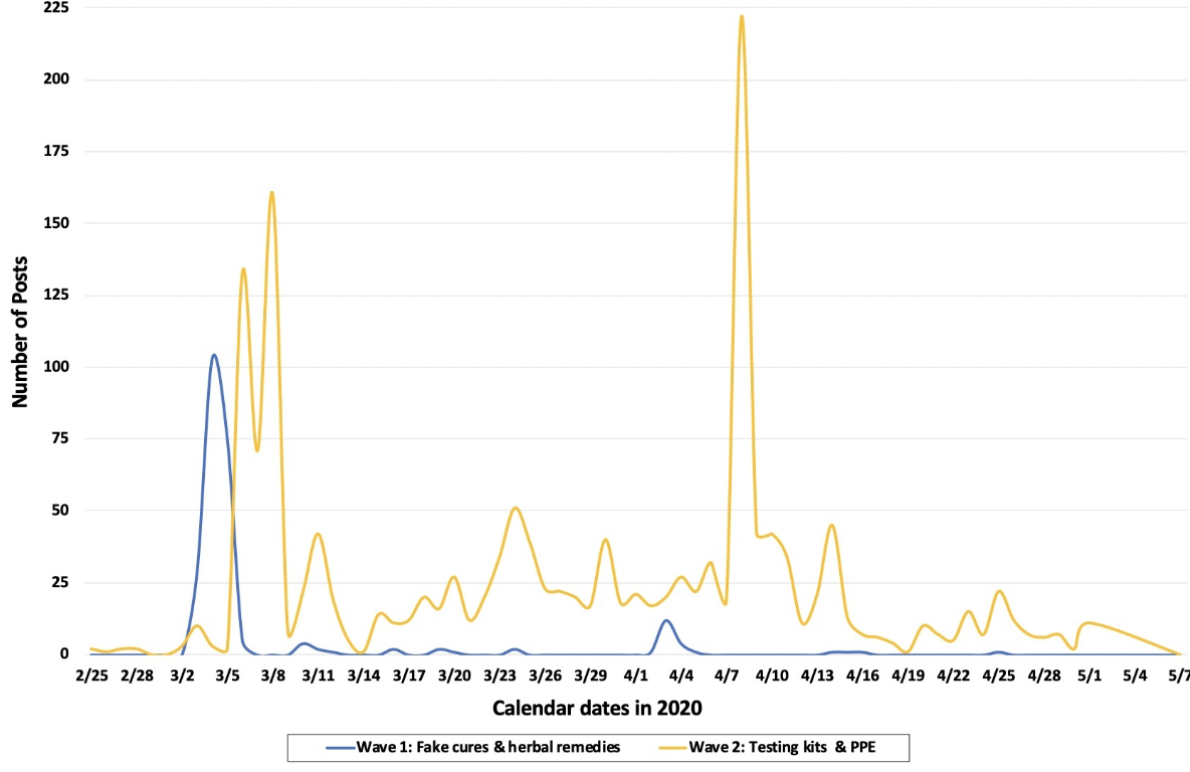
Table 1. Twitter and Instagram posts associated with questionable sales of COVID-19–related products.